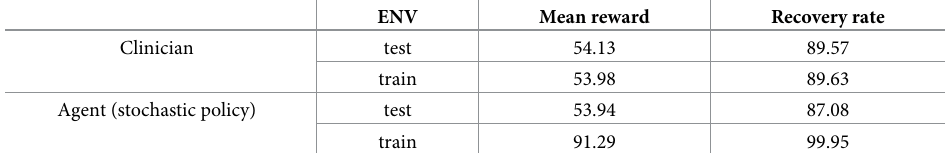
Table 2. Performance comparison of the agent and the clinicians after 10 000 simulated patient trajectories in the evaluation environment ( n = 10000, 28-day mortality).